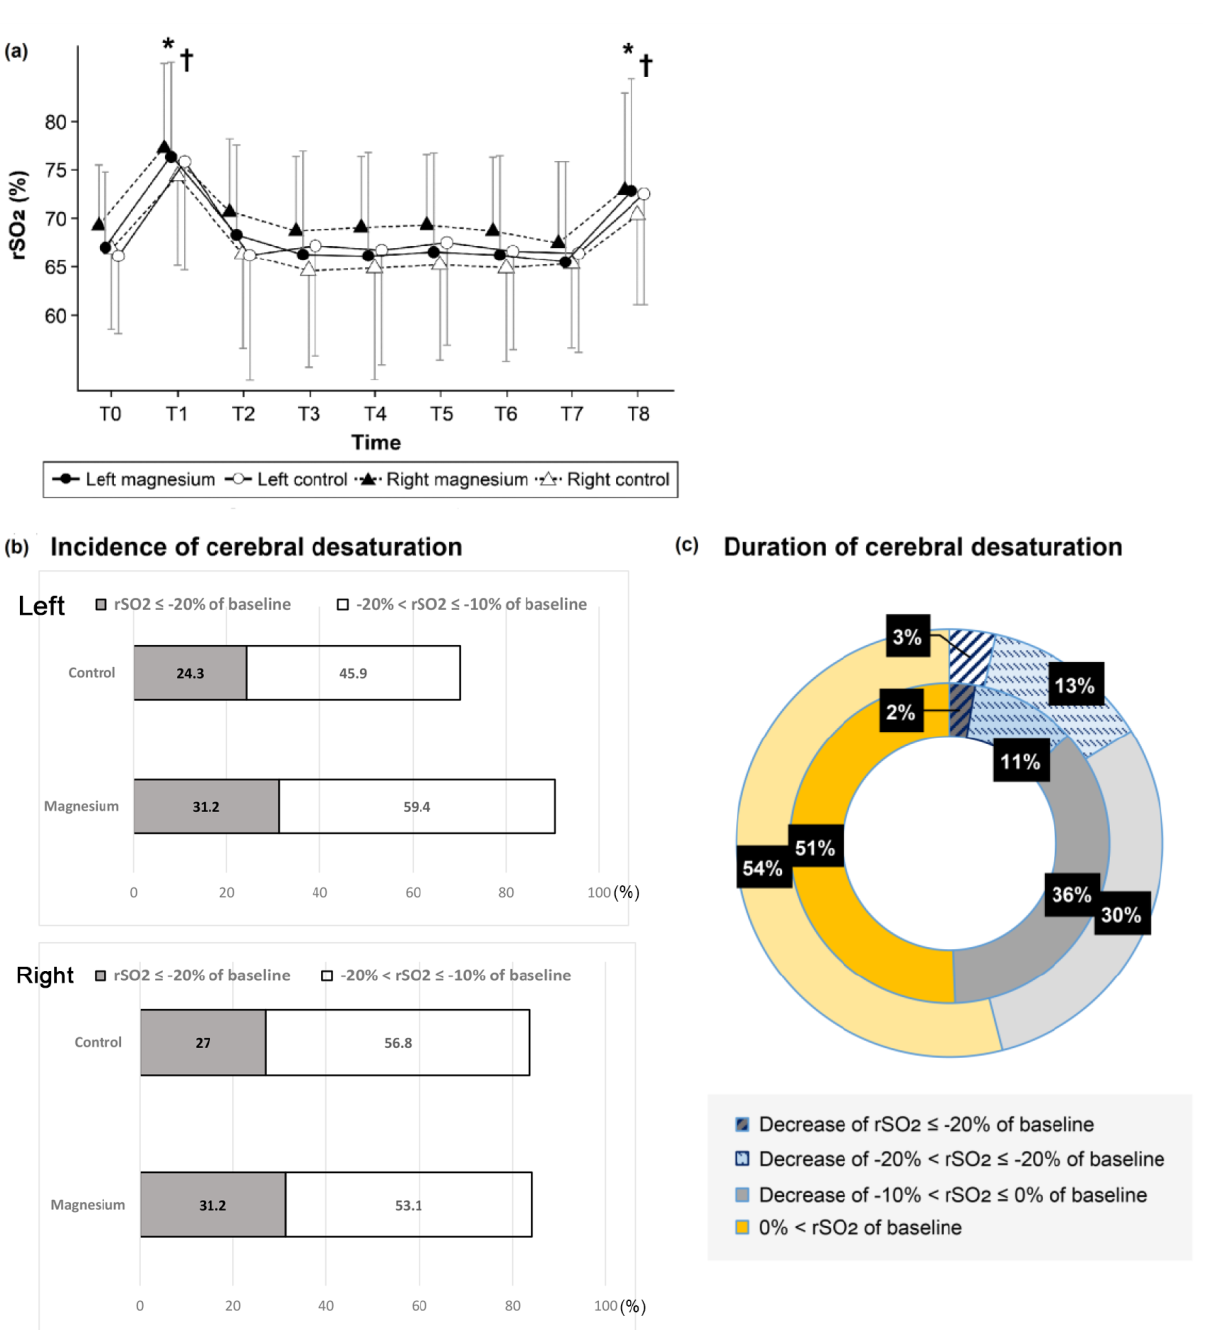
Figure 2. Representative values of regional cerebral oxygen saturation (rSO 2 ) in the operating room. ( a ) Time trend of rSO 2 . T0: baseline at admission to operating room (OR), T1: Mg bolus administration, T2: Mg continuous infusion, T3–T6: 10, 20, 30, 40 min after Mg infusion, T7: end of surgery, T8: leaving the OR. ● Left ▲ Right ● Magnesium ○ control. ( b ) Incidence of percentage decreases in rSO 2 (%), below or equal to minus 20% and below or equal to 10% to less than 20% relative to each baseline value. ( c ) Duration of percentage decreases in rSO 2 (%). The inner circle is the Magnesium group. The outer circle is the Control group. * p < 0.05 from baseline value in Magnesium (Mg) group, † p < 0.05 from baseline value in control group.